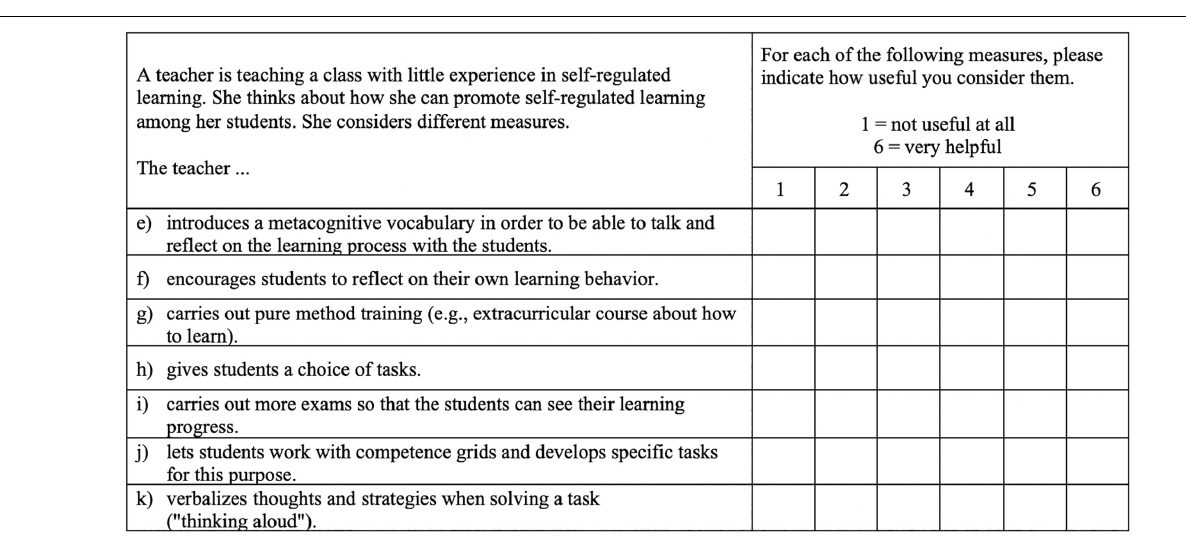
FIGURE 3 | Sample scenario of the test to assess teacher PCK-SRL. The displayed scenario has not been included in the final test